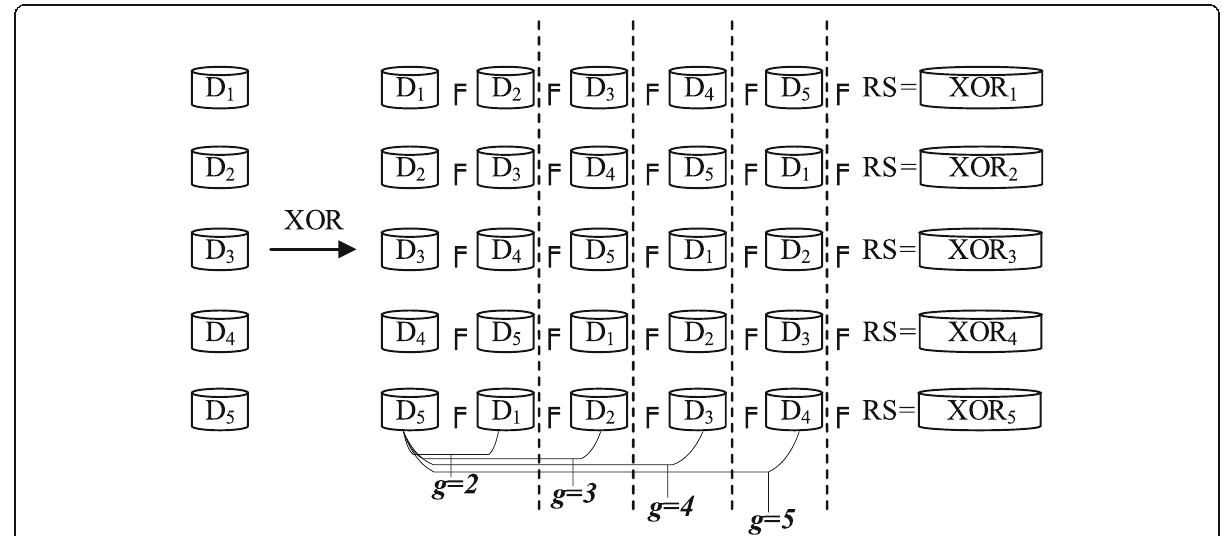
Fig. 3 XOR-encrypted backup data generation at x =